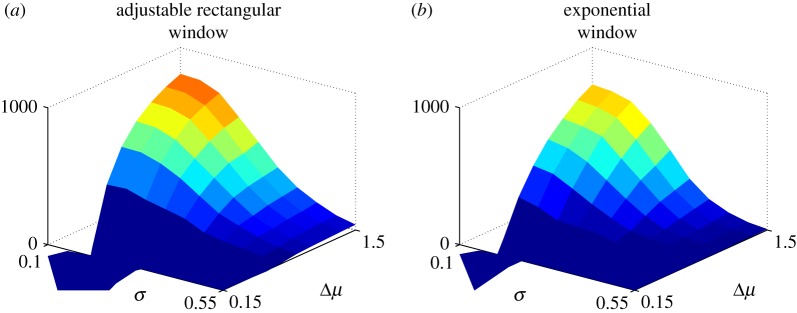
Comparison of cumulative reward R in epoch 2 from problem specific windows with rectangular and exponential form using the protocol in equation (3.5) (each averaged over 1000 runs). Panel (a) shows results for the rectangular window; panel (b) shows results for the exponential window (repeated here from figure 5 for ease of comparison).